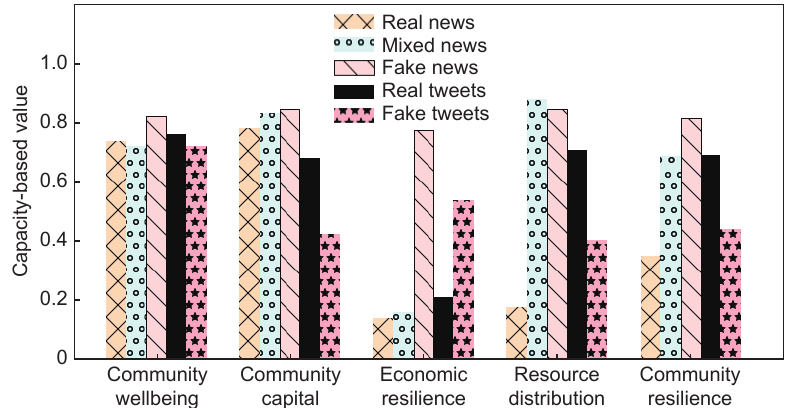
Fig. 9 Capacity-based analysis of community wellbeing, community capital, economic resilience, resource distribution, and community